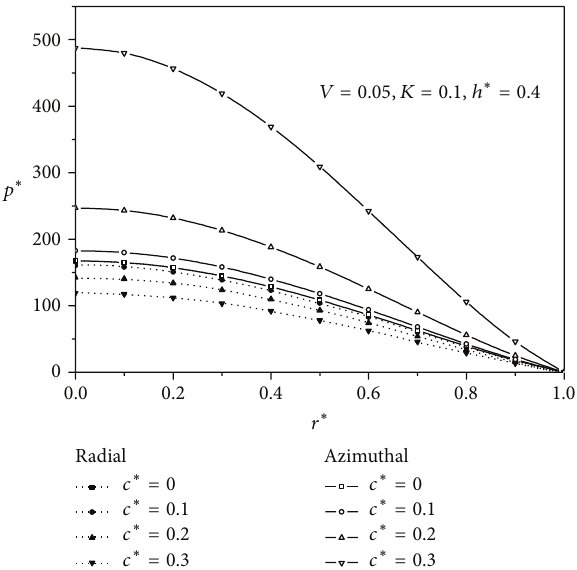
Figure 2: Film pressure 𝑝 ∗ versus radial coordinate 𝑟 ∗ for different 𝑉 and 𝐾 . Figure 3: Film pressure